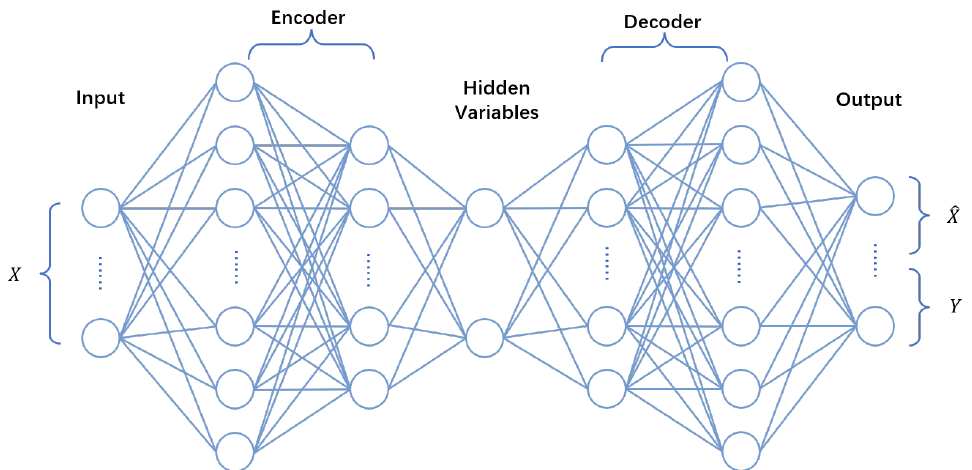
Figure 4. Structure of the variational autoencoding classifier. Compared with the variational autoen- coder, the variational autoencoding classifier includes a new output Y . X represents the input data, Y represents the label of the input data, and ˆ X represents the reconstruction of the input